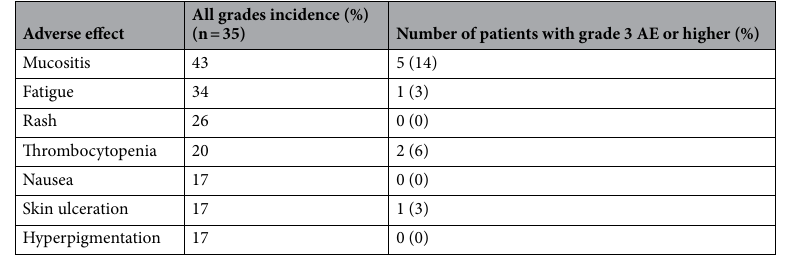
Table 2. Table displaying the incidence of adverse effects (AE) in patients receiving Evo 670 mg/m 2 in combination with Bevacizumab 10 mg/kg IV every 2 weeks (n = 35). Adverse effects with all grades incidence lower than 10% are not included in this table, Grade 2 Anemia had highest incidence among this group (2%) with no reported Grade 3 or higher Anemia.